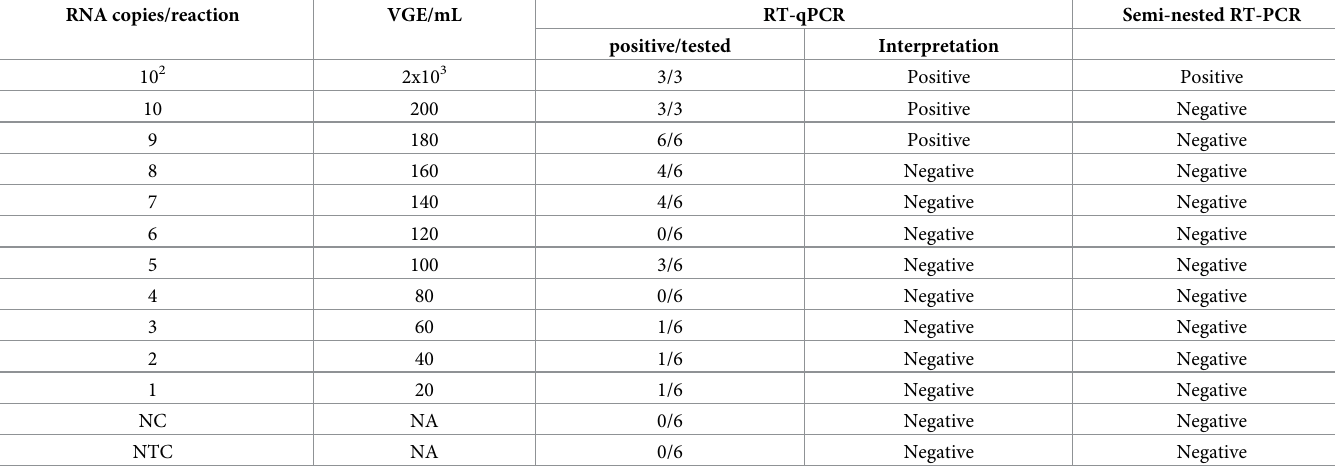
Table 3. Detection limit of hantavirus RT-qPCR and Semi-nested RT-PCR assays. RNA